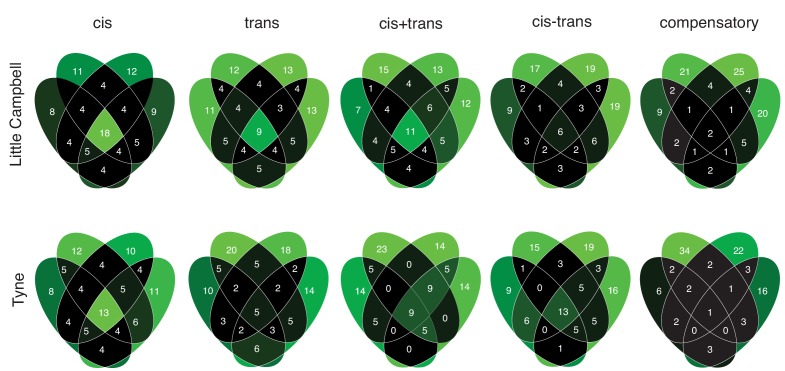
Sharing of regulatory divergence between siblings as a proxy for the level of epistasis associated with different genetic architectures in Little Campbell (see also main text Figure 6b) and Tyne.The type of regulation observed for each gene is compared among siblings (overlapping ovals) with numbers representing percent of loci shared between siblings (rounded to integer). Color scale ranges from black (low) to pale green (high). Cis-regulatory divergence tended to be most stable across genetic backgrounds indicating that cis-acting divergence is least influenced by epistasis.